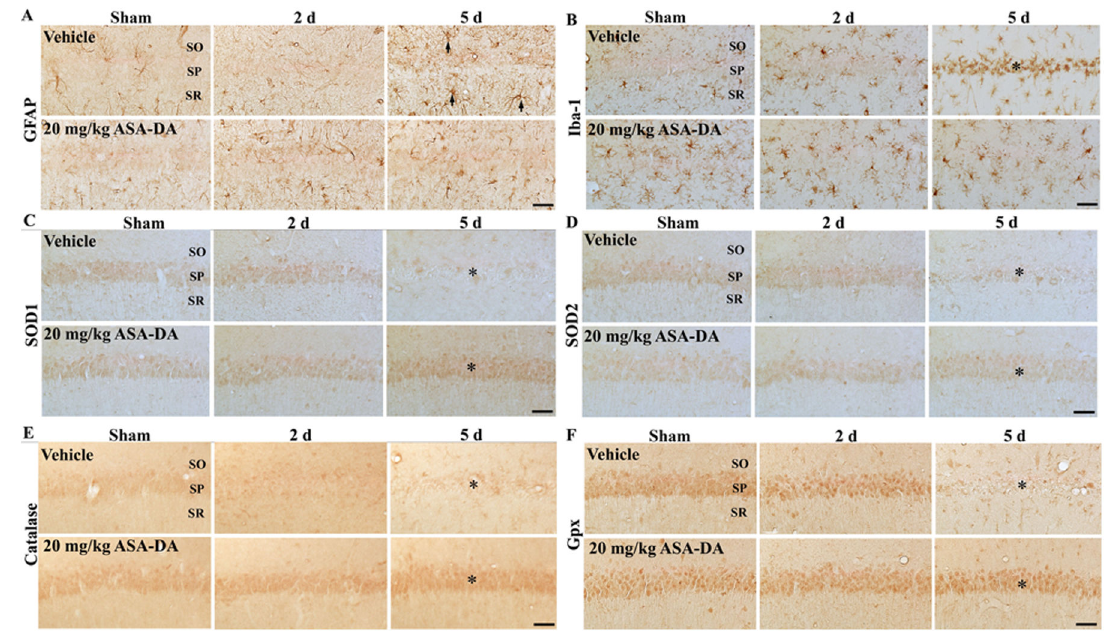
Figure 6. GFAP (A), Iba-1 (B), SOD1 (C), SOD2 (D), CAT (E) and Gpx (F) immunohistochemistry. All of them in the CA1 region of the vehicle- and 20 mg/kg ASA-DA-pre-ischemia-groups at sham, 2 and 5 days after ischemia-reperfusion. In the vehicle- ischemia-group at 5 days post-ischemia, GFAP immunoreactivity increases in all the layers, and Iba-1 immunoreactivity is aggregated in the stratum pyramidale (SP). In the 20 mg/kg ASA-DA-pre-ischemia-group at 5 days post-ischemia, GFAP and Iba-1 immunoreactivity are much lower than those in the vehicle-ischemia-group at 5 days post-ischemia-group. In the vehicle-ischemia- group at 5 days post-ischemia, SOD1, 2, CAT and Gpx immunoreactivity are weakly detected in the stratum pyramidale. However, their immunoreactivity is well maintained or increased in the stratum pyramidale of the 20 mg/kg ASA-DA-ischemia-group at 5 days post-ischemia. SO; stratum oriens, SR; stratum radiatum. Scale bar = 50 µm. doi: